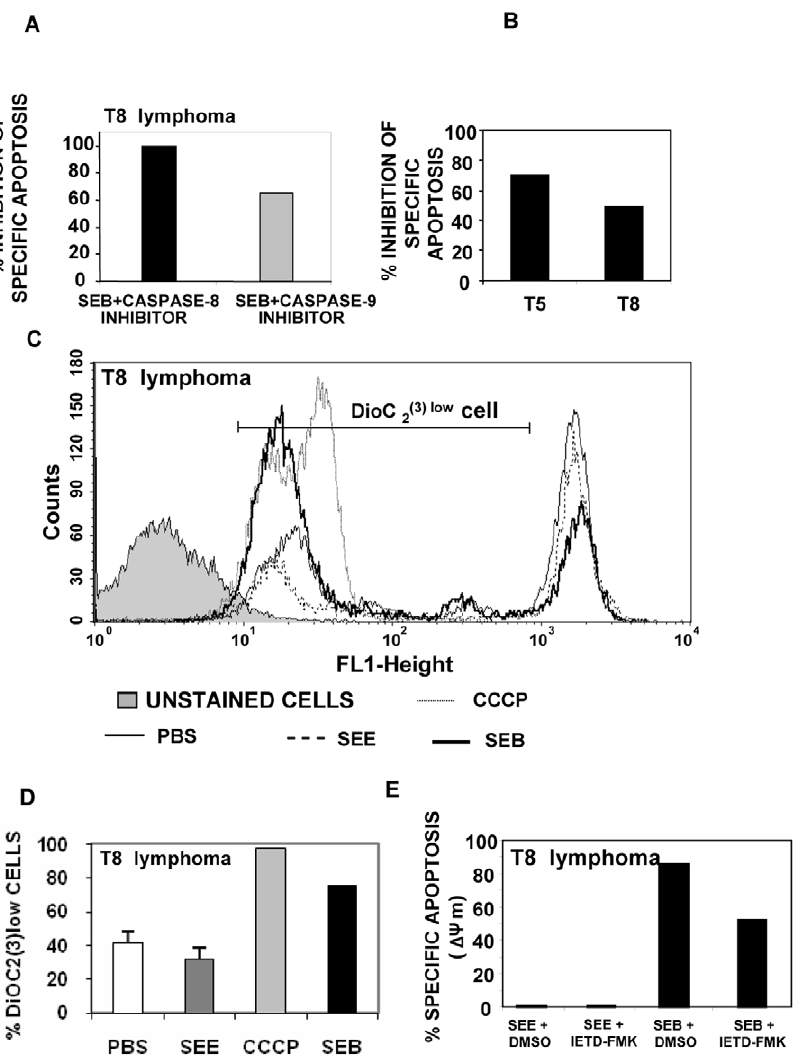
Figure 6. Mechanisms involved in Sag-induced apoptosis. A) Inhibition of Sag-induced apoptosis of lymphoma cells by caspase-8 and caspase-9 inhibitors. T8 cells (2.5 6 10 5 ) co-cultured with peritoneal macrophages (0.7 6 10 5 ) were treated during two hours with 25 m M of Z-IETD-FMK (caspase-8 inhibitor), Z-LEHD-FMK (caspase-9 inhibitor) or DMSO prior to the addition of 10 m g/ml of SEB or PBS. At day 3, cells were recovered, stained with Annexin/7- AAD and analyzed by FACS. The percentage of specific apoptosis was calculated as follows: 100 6 (% Sag induced apoptosis - % spontaneous apoptosis with PBS)/(100 - % spontaneous apoptosis with PBS). Inhibition of apoptosis by caspase inhibitors was calculated as reduction of specific apoptosis compared to specific apoptosis in the presence of DMSO set as 100%.(B) Inhibition of apoptosis by Fas-Fc fusion protein. T5 or T8 cells (2.5 6 10 5 ) co-cultured with peritoneal macrophages(0.7 6 10 5 )weretreatedwithSEI,SEB(10 m g/ml)orPBS.Ten m g/mlofFas-Fc,HuIgGorPBSwereaddedatday2.Atday4,cellswereharvestedand stained with Annexin V-7AAD. Specific apoptosis was calculated as described in (A). Inhibition was calculated as reduction of apoptosis compared toapoptosis inthe presence of HuIgGset as 100%. (C–D) Sags cause mitochondrial depolarization in cognate lymphoma T cells. T8lymphoma cells (2.5 6 10 5 ) were cultured in the presence of 10 m g/ml of SEE, SEB or PBS as described in Material and Methods. Cells were harvested 72 hours after Sag exposure and the mitochondrial membrane potential ( Dy m) was measured by FACS using DiOC 2 (3) staining. Representative overlayed histograms for DiOC 2 (3) fluorescence are depicted in (C).(D) Show the percentage of DiOC 2 (3) low cells. Data are expressed as the mean 6 SD. *p , 0.05. (E) Caspase-8 inhibitor decreases the loss of Dy m induced by SEB. T8 lymphoma cells (0.25 6 10 6 ) were incubated with 25 m M Z-IETD-FMK or DMSO for 2 hours before exposure to 10 m g/ml of SEE, SEB or PBS. Cells were harvested72 hourslaterand Dy